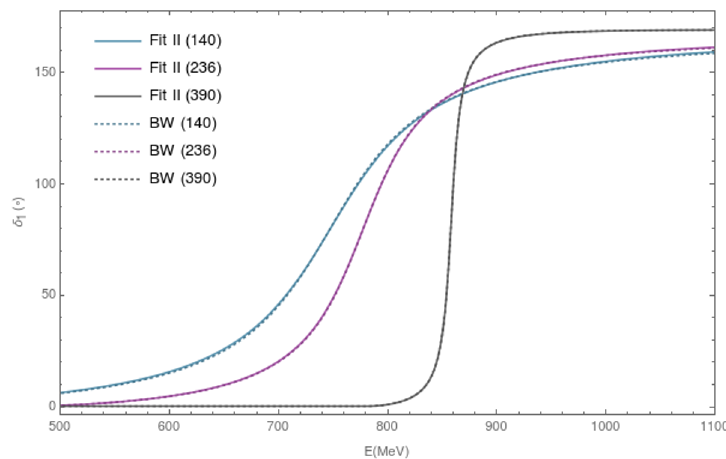
Figure 42 . Breit-Wigner (BW) reanalyses of the phase shifts obtained in Fit II with IAM for the HadSpec masses and the extrapolation to the physical point. The (cid:12)gure shows that the behavior is compatible with a BW parameterizations and BW resonance parameters can be extracted. The BW results of the individual (cid:12)ts of sections 4.1 and 4.2 are comparable with the values given in the lattice